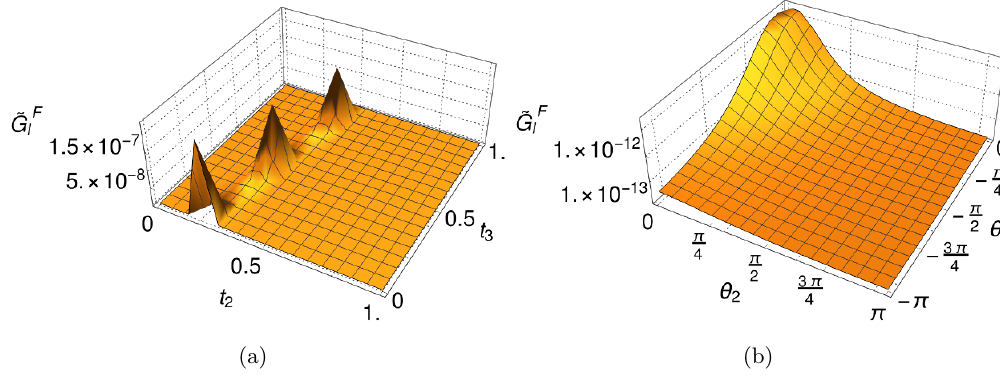
Figure 11 . A slice of the absolute value of the I246 1 integrand at O ( (cid:15) 0 ) in the second over-threshold region (a) without a complex mapping, t 0 = 1, t 1 = 1